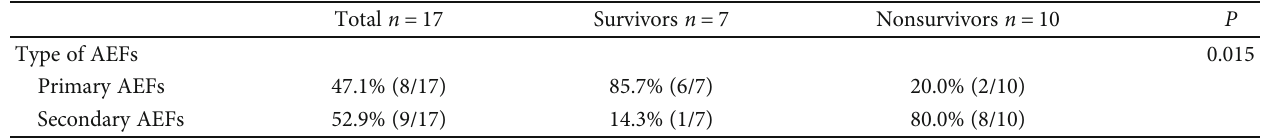
Table 2: Survival data for mycotic AA in AEF